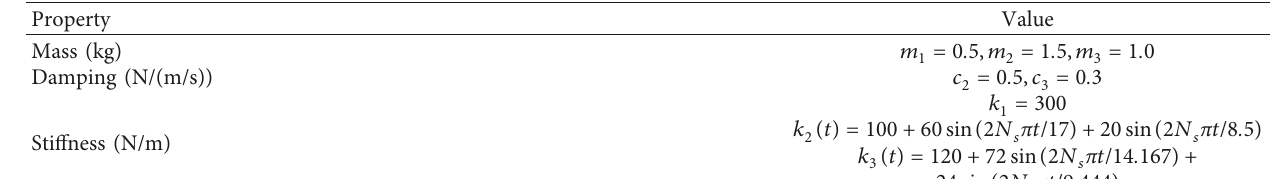
Table 1: Numerical values of the system